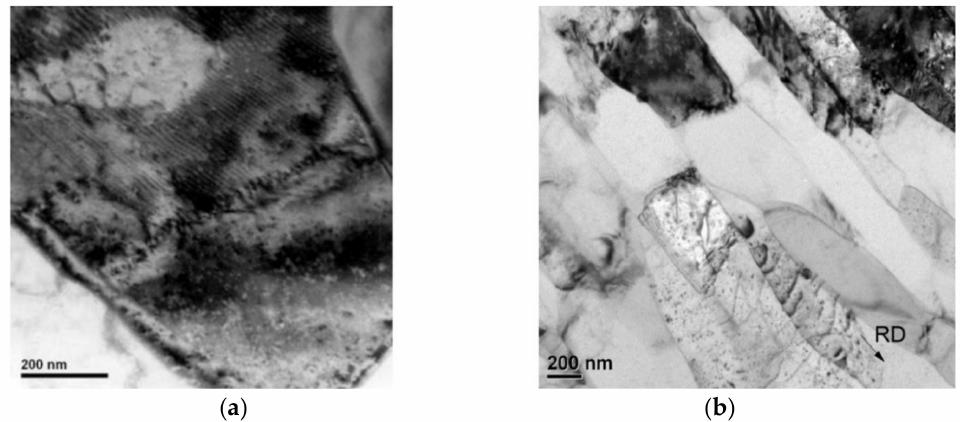
Figure 38. ( a ) TEM micrograph of pure Al after asymmetric cold rolling, reproduced from [149], with permission from Elsevier, 2009; ( b ) TEM micrograph of Al 1050 after asymmetric cryorolling [24] (RD—rolling